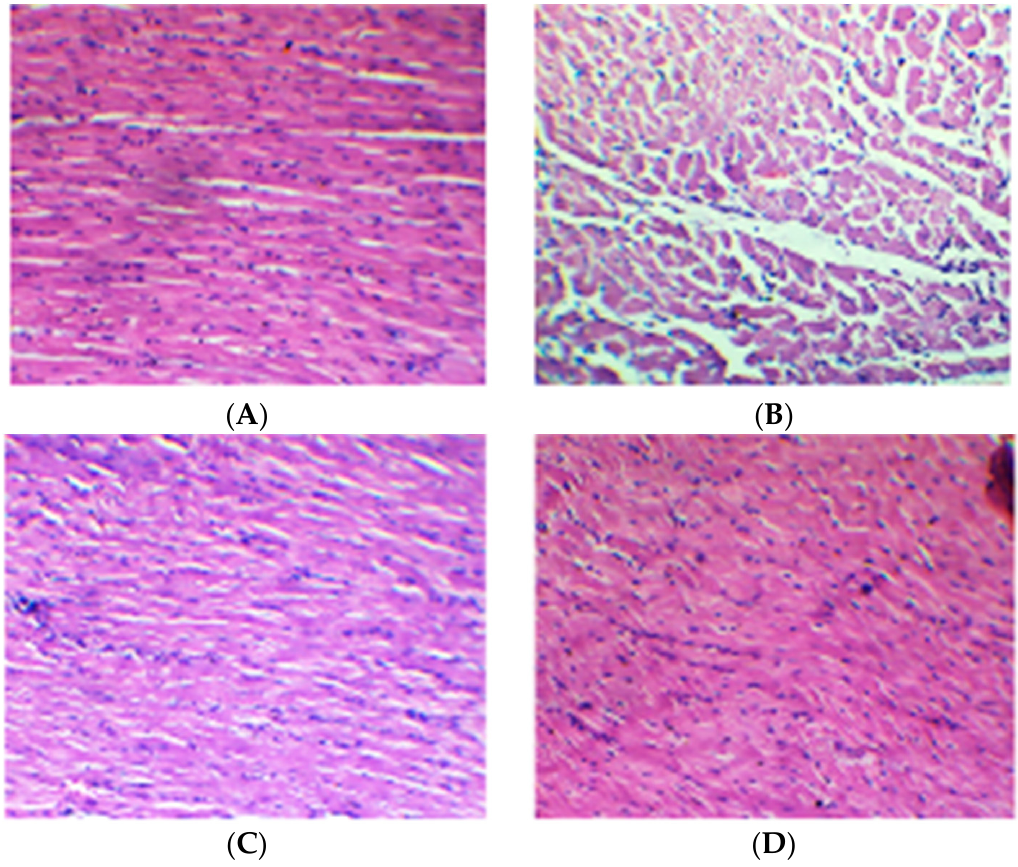
Figure 2. Effect of cardamom on histopathology in the isoproterenol-induced myocardial infarction in rats. Myocardial light micrograph (Magnification 100×): ( A ) normal group received saline showing normalarchitecture of myocardium; ( B ) diseased control group received two subcutaneous injections of ISOshowing necrosis of myofibrils and edema through penetration of inflammatory cells andextravasations of red blood cells; ( C ) cardamom 100 mg/kg treated group showing lessermyocardial necrosis and edema following ISO administration; and ( D ) cardamom 200 mg/kg treated group showing conical myocardial necrosis and edema following ISO administration. Table 5. Effect of cardamom on histopathological changes in the isoproterenol-induced myocardial infarction in rats. Treatments Myonecrosis Inflammation